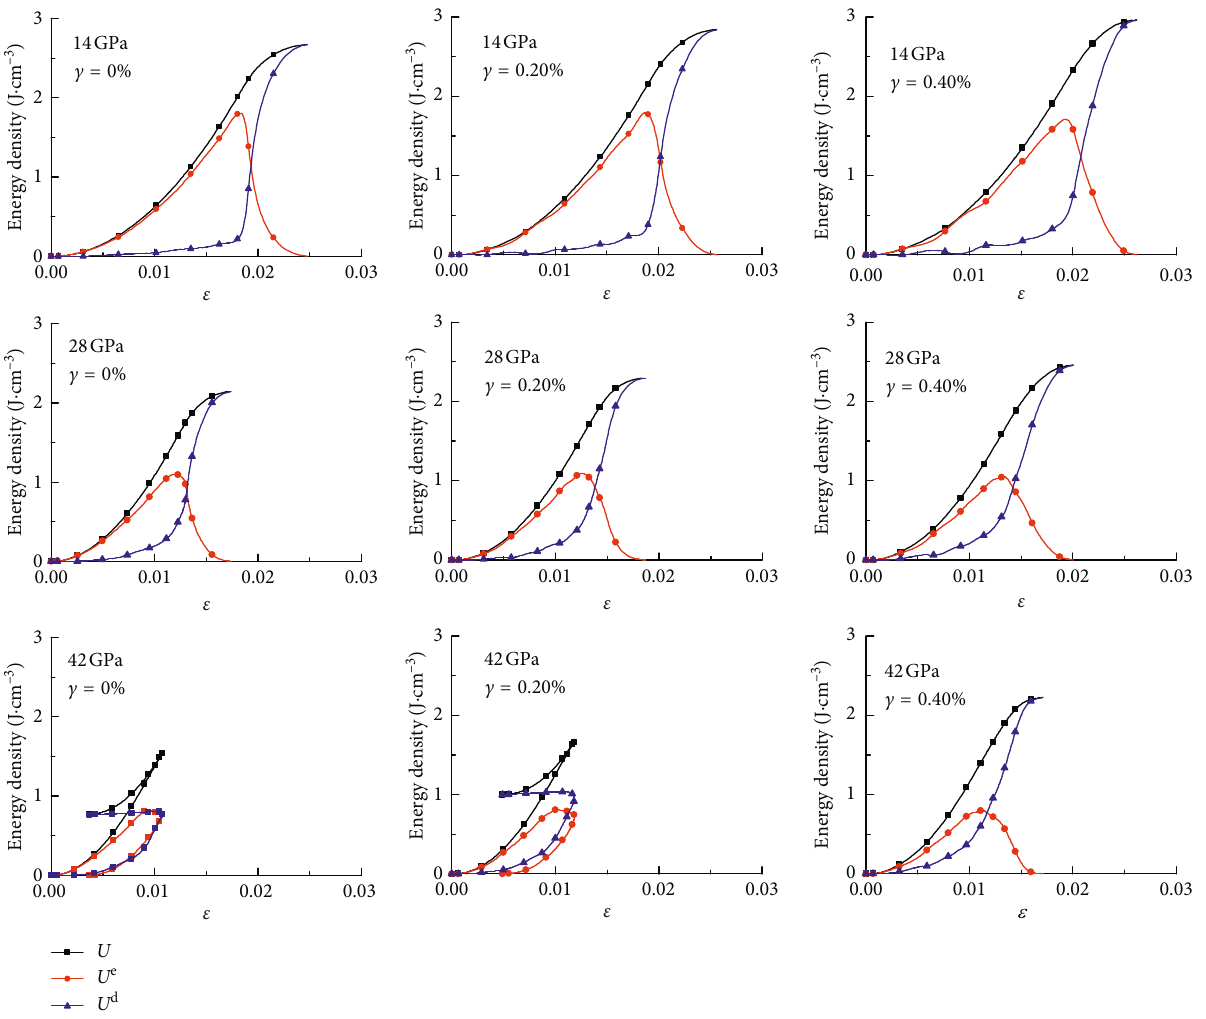
Figure 7: Energy density evolution curves of the rocklike specimen. Table 2: Releasable elastic strain energy density and dissipated energy density at peak dynamic stress (unit: J · cm − 3